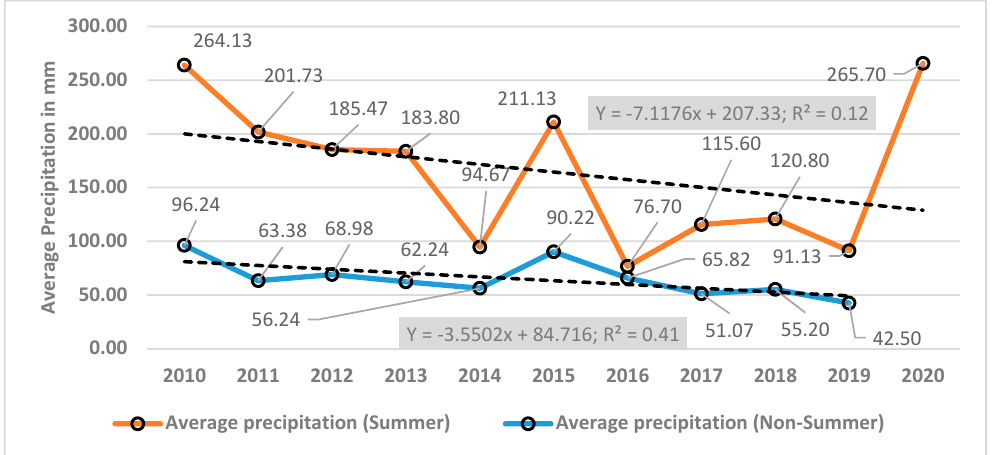
Figure 7. Variations in the trend of average precipitation between summer and non-summer seasons from 2010 to 2020.